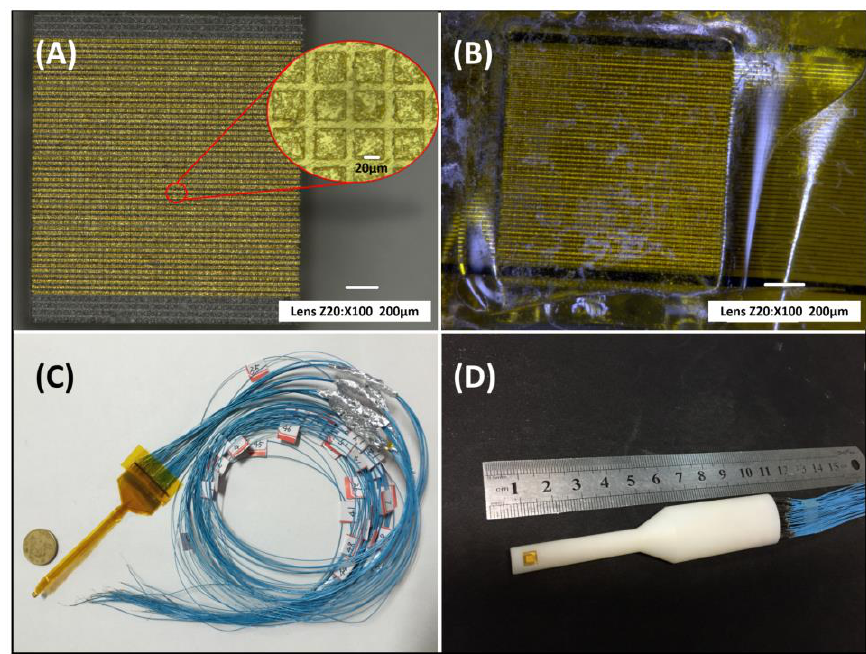
Figure 2. Photographs of ( A ) Au patterned PIN-PMN-PT single crystal 1-3 composite ( B ) with Flexible